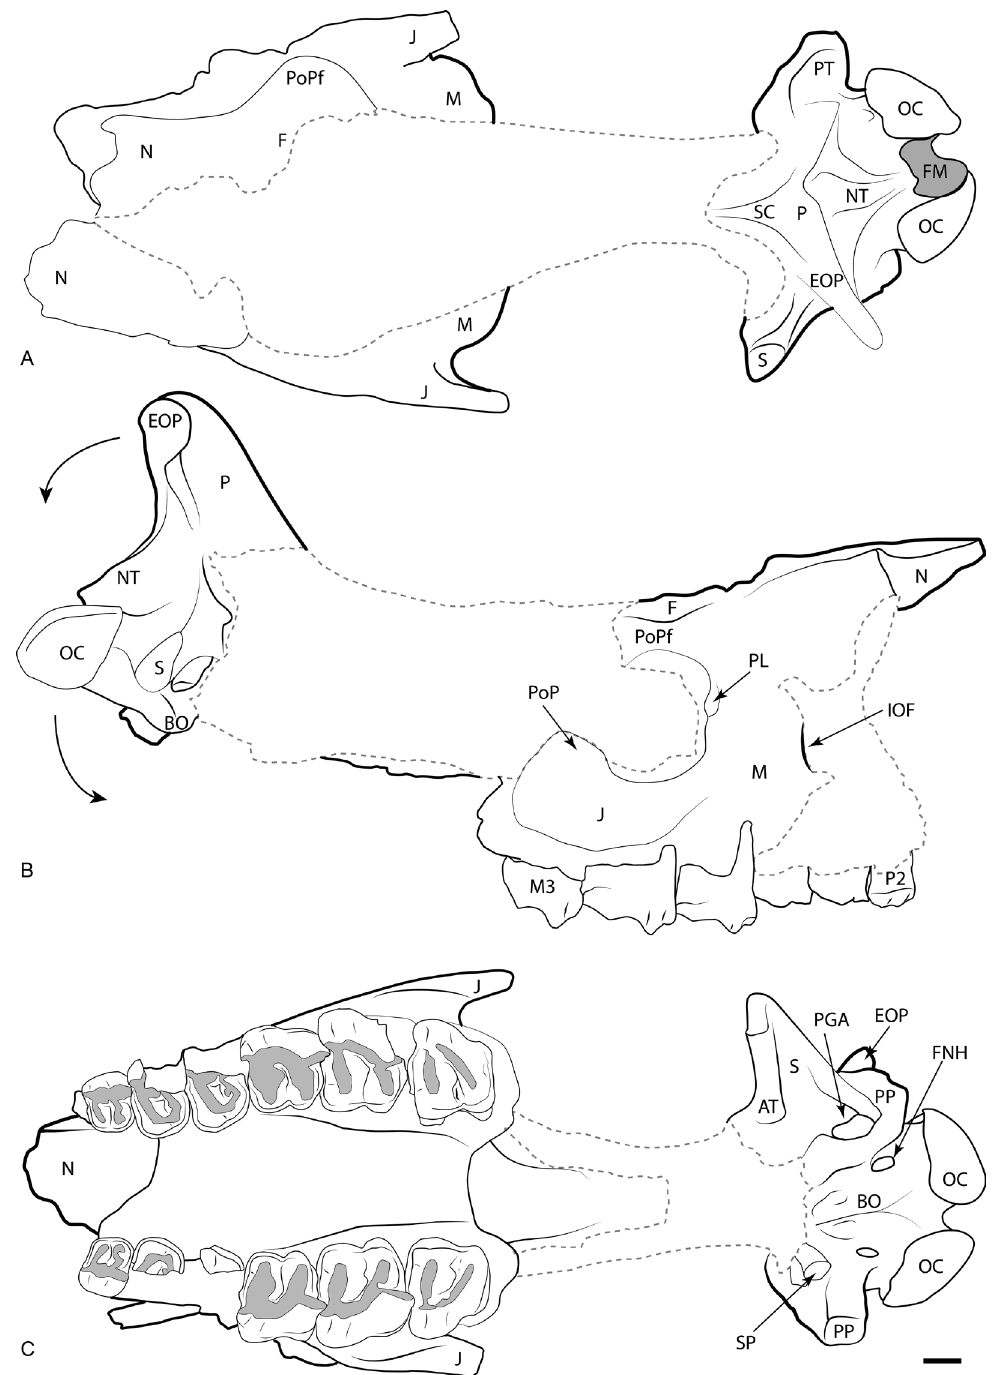
Fig. 9. Ronzotherium elongatum Heissig, 1969 from Pernes (early Oligocene?). Drawing of the skull FSL-9601. A . Dorsal view. B . Right lateral view. C . Ventral view. The arrows indicate the hypothetical position of the posterior part of the skull. Abbreviations: AT = articular tubercle; BO = basioccipital; EOP = external occipital process; F = frontal; FM = foramen magnum; FNH = foramen nervi hypoglossi; IOF = infraorbital foramen; J = jugal; M = maxilla; N = nasal; NT = nuchal tubercle; OC = occipital condyle; P = parietal; PGA = postglenoid apophysis; PL = processus lacrimalis; PoP = postorbital process; PoPf = postorbital process of the frontal; PP = paraoccipital process; PT = posttympanic; S = squamosal; SC = sagittal crest; SP = styloid process. Scale bar: 2